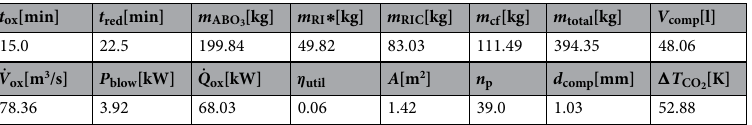
˙ Q th (cid:30) of 27.5kW . (cid:31)